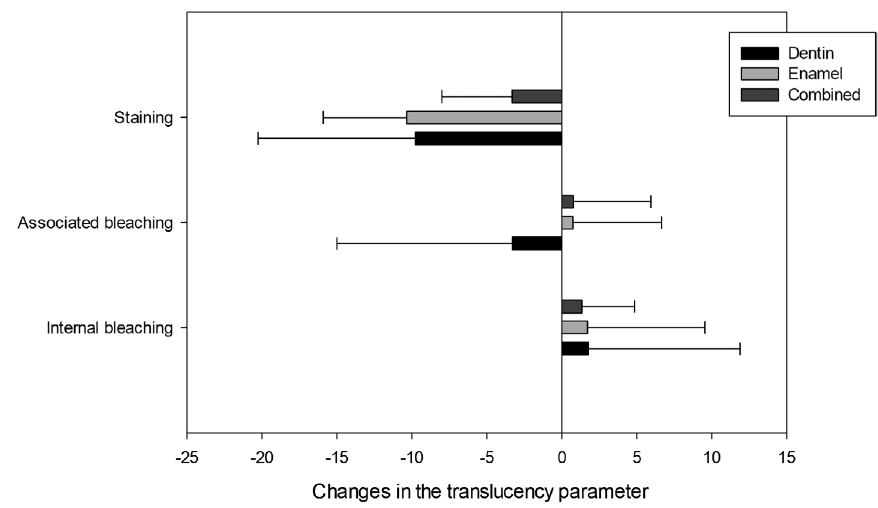
Figure 4- Changes on translucency parameters of dentin, enamel, and combined tissues caused by staining or bleaching